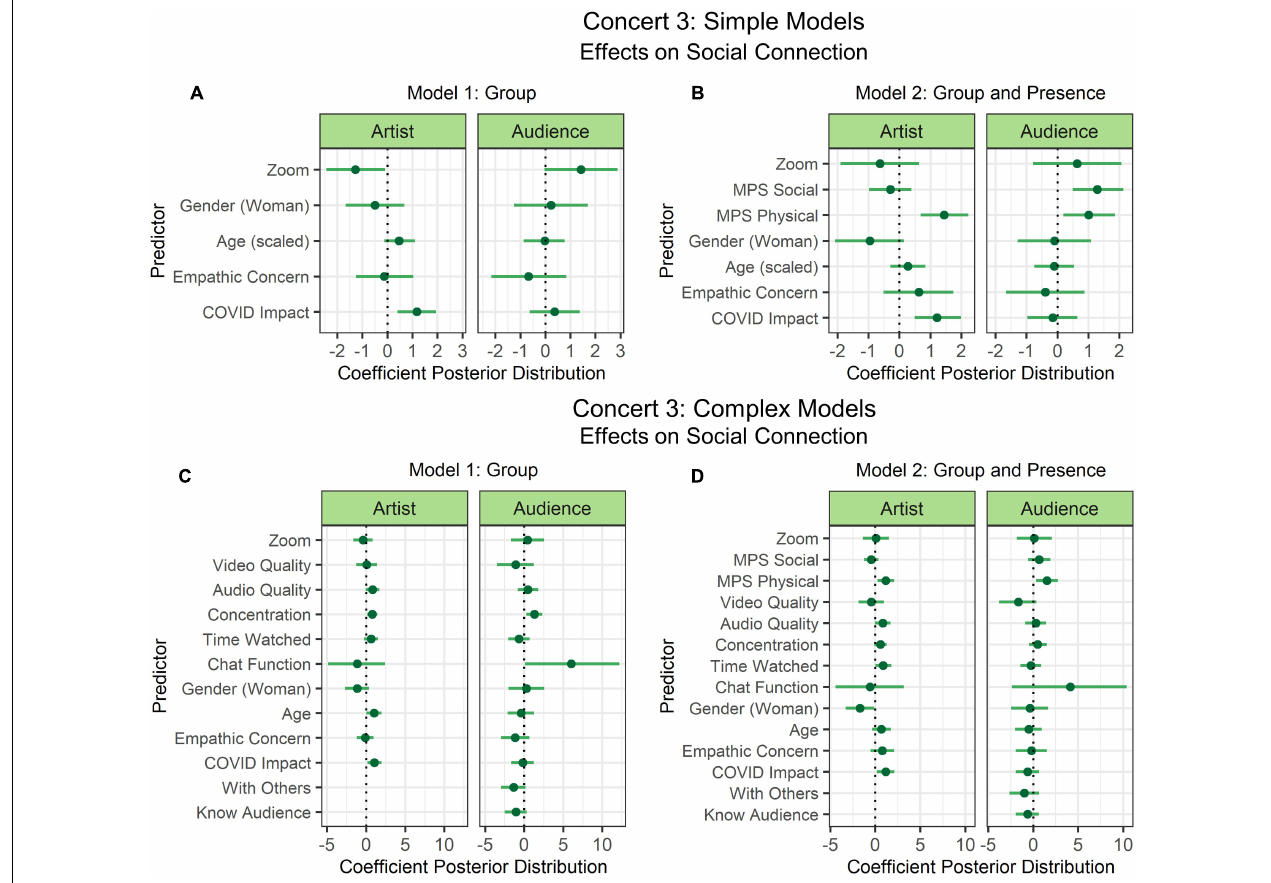
FIGURE 7 | Concert 3’s simple (A,B) and complex (C,D) models’ predictor coefficient estimates (points) and 90% credible intervals (lines) for the effects on social connection to the artist (left) and audience (right). Two models were fit to examine the individual effect of the experimental manipulation from groups (A,C) and the combined effects of group and presence (B,D)